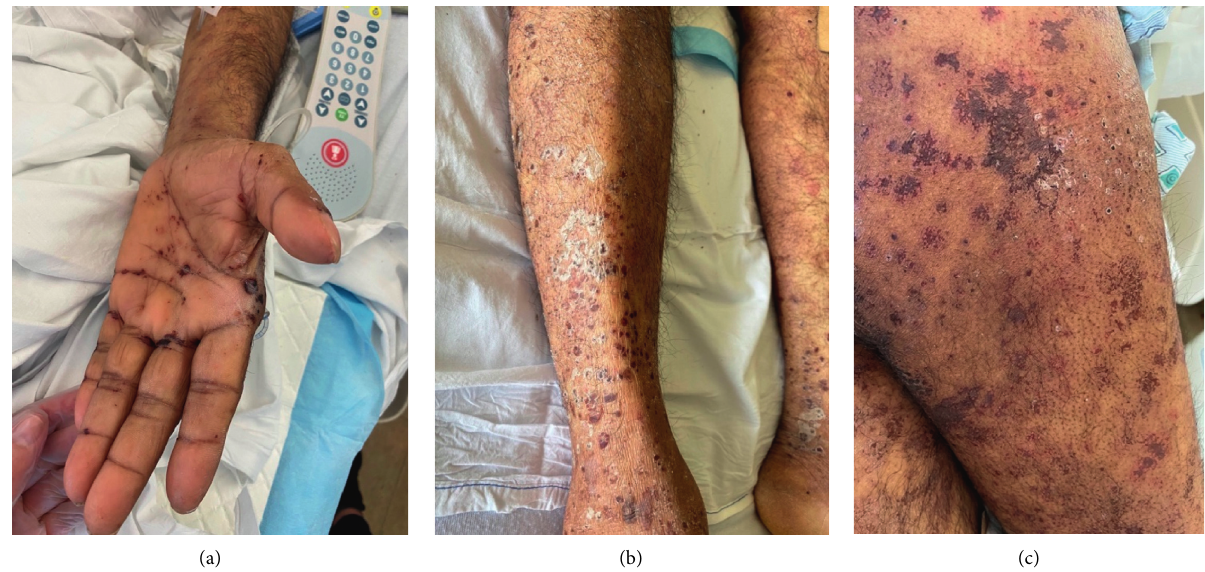
Figure 2: Cutaneous findings in a 46-year-old man with granulomatosis with polyangiitis and an active COVID-19 infection. (a) Purpuric macules and papules on palm and distal arm (b) Purpuric macules and papules with collarettes of scale on lower leg. (c) Retiform purpuric patches on